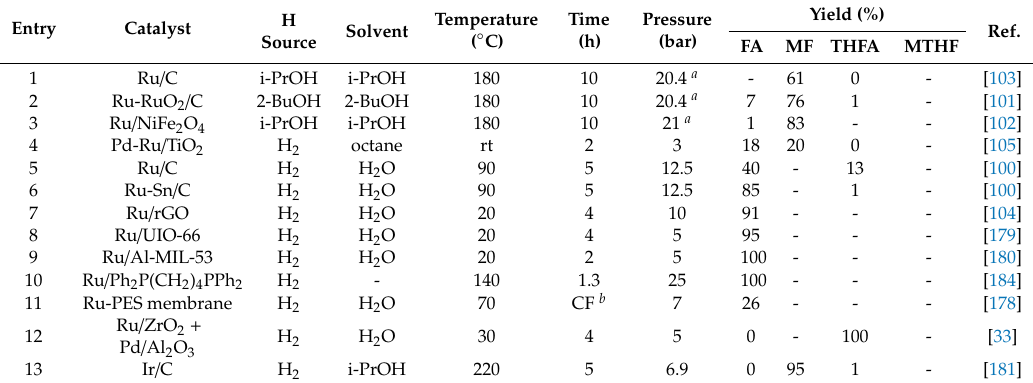
Table 6. Furfural hydrogenation over Ru-based and other